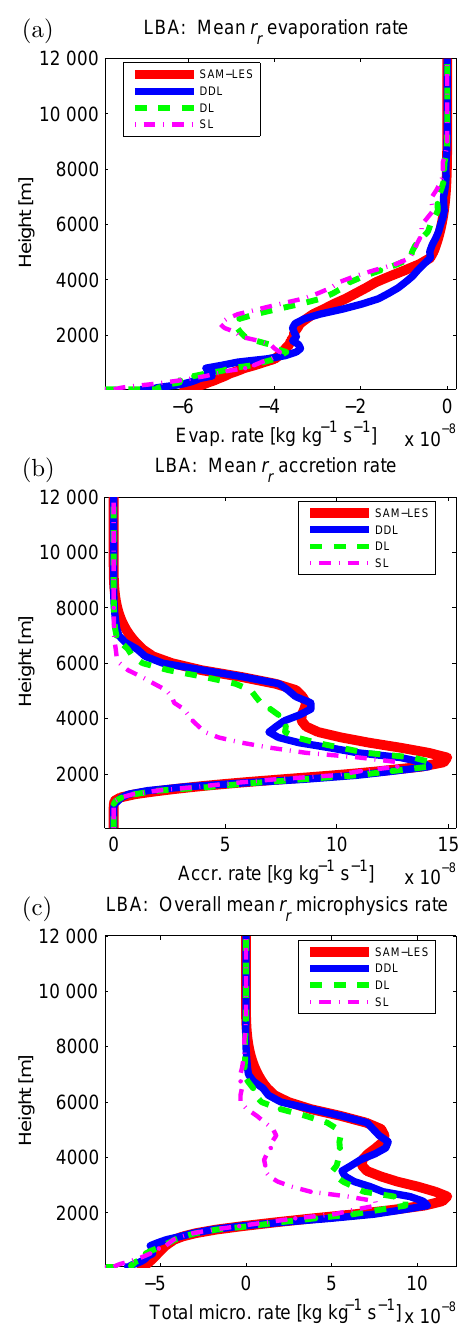
Figure 9. Profiles of mean warm microphysics process rates in the LBA deep convective case time-averaged over the last hour of the simulation (minutes 300 through 360). The SAM LES results are red solid lines, the DDL results are blue solid lines, the DL re- sults are green dashed lines, and the SL results are magenta dashed- dotted lines. (a) The mean evaporation rate of r r . (b) The mean ac- cretion rate of r r . (c) The overall mean microphysics tendency for r r . Again, the DDL provides a better fit to SAM LES than the DL, which in turn provides a better fit than the SL.